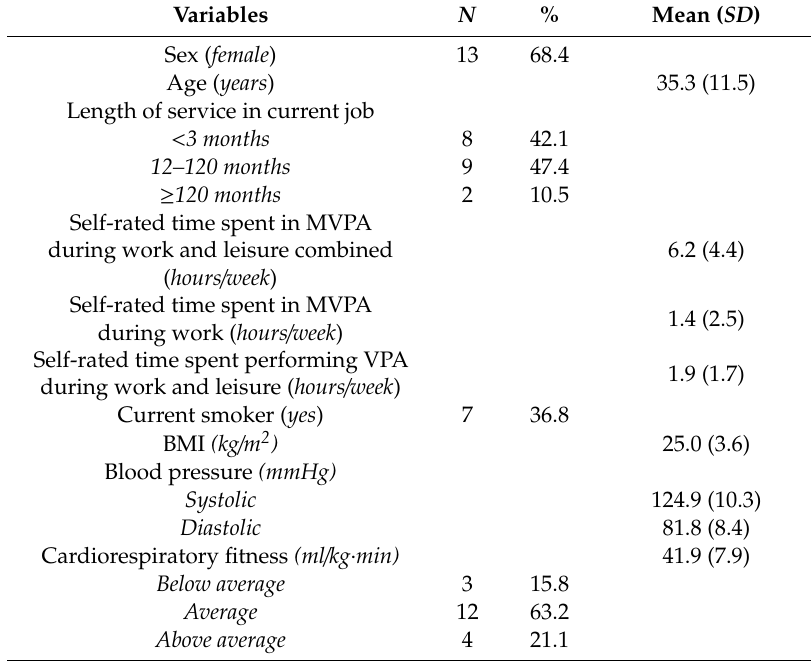
Table 1. Demographic and fitness characteristics of the childcare workers ( n =